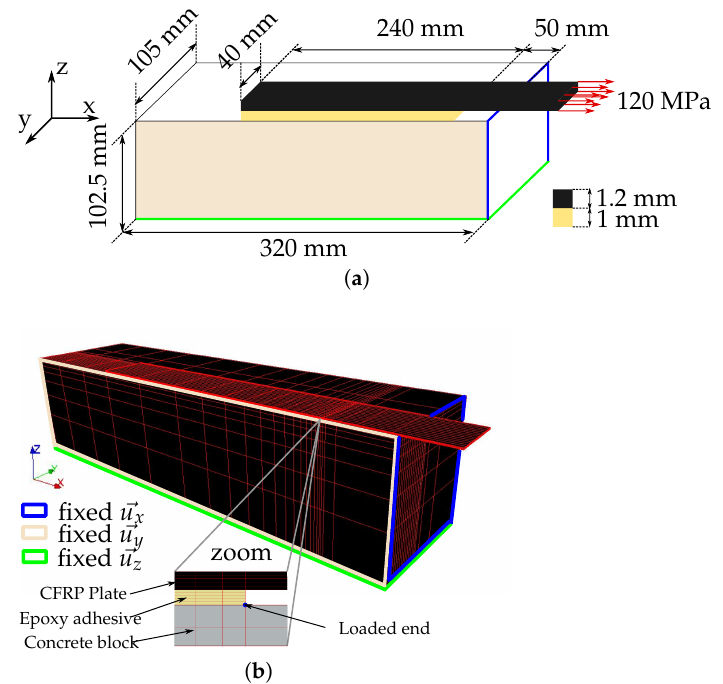
Figure 5. ( a ) Schematic representation and mesh of the double shear test, ( b ) associated FE mesh in